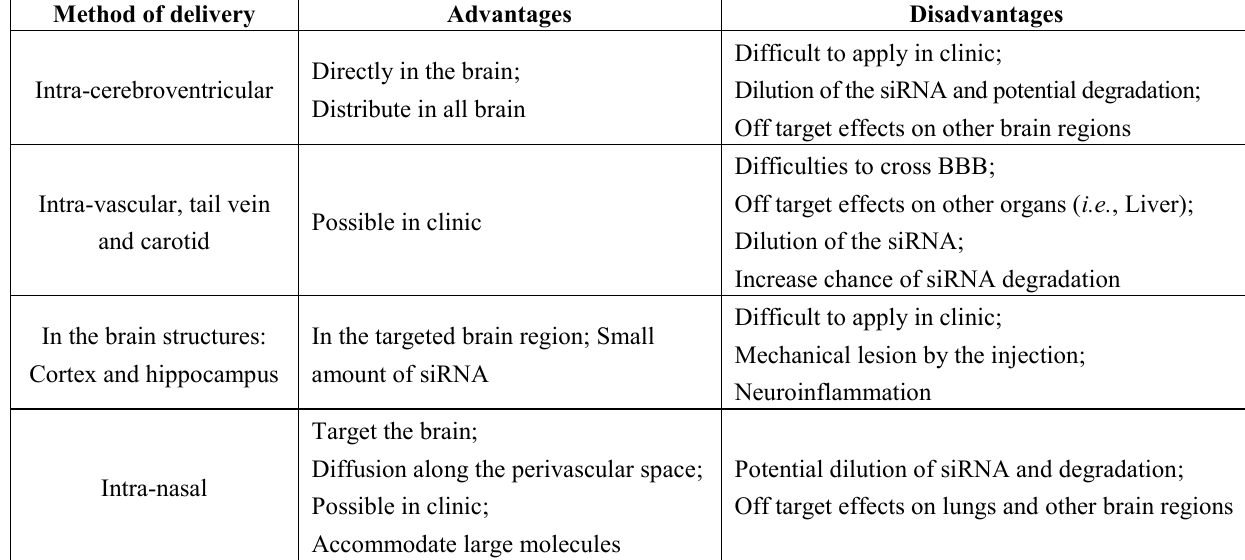
Table 4. Advantages and disadvantages of each delivery method of